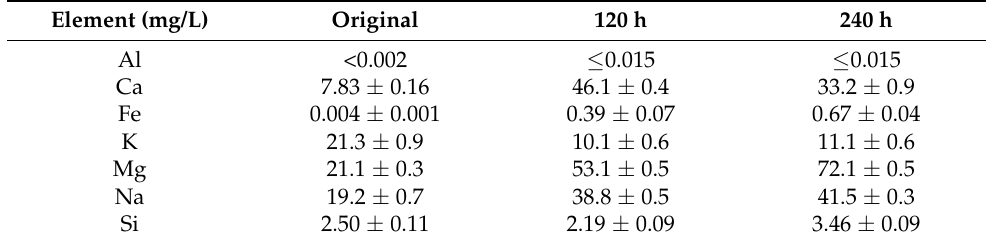
Table 2. Al, Ca, Fe, K, Mg, Na, and Si in the supernatant reaction solutions by ICP-EOS. Element (mg/L)